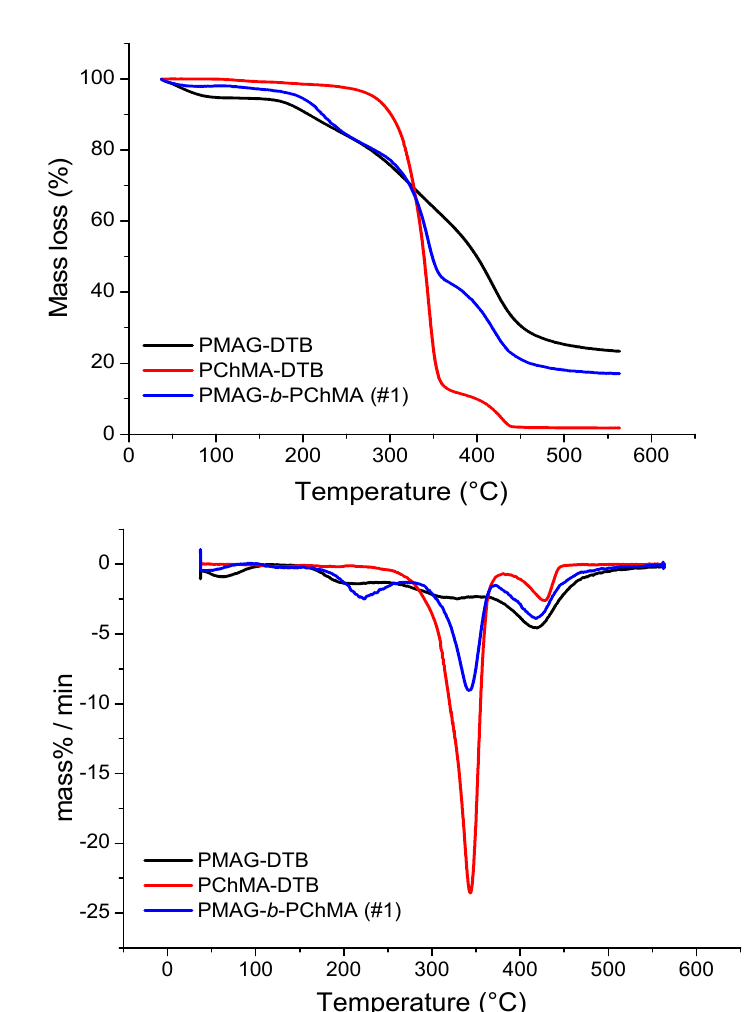
Figure 6. TGA ( A ) and DTG ( B ) plots for PMAG, PChMA, and their copolymer. The analysis of thermograms of PVSI-containing block-copolymers and their homopolymers (Figure 7) showed an increase in thermal stability alongside an increase in the proportion of PVSI in the block-copolymer. Destruction of the PVSI homopolymer proceeds after 400 ° C, and the mass loss of 7 % up to 200 ° C can be related to the solvent traces. Block-copolymers with different contents of PVSI and PChMA blocks show two stages of destruction on the thermograms. The temperatures of these processes appeared to be closer to those detected for the corresponding homopolymers for which the block-copolymers were enriched. Therefore, the thermogram for sample #2 (Table 1), which was enriched with PVSI fragment, was closer to the PVSI homopolymer. At the same time, sample #3, enriched with PChMA fragment (Table 1), had temperatures of mass loss closer to the PChMA homopolymer. The thermal stability of the amphiphilic block-copolymer was significantly reduced in comparison to the non-hydrolyzed PVSI-containing analog. The destruction of PVSAA- b -PChMA- b -PVSAA copolymers occurs in three main steps. The first step is responsible for the decomposition of the side chain of PVSAA, the second refers to the degradation of the side chain of PChMA, and finally, the third indicates the decomposition of the remaining polymer backbone.